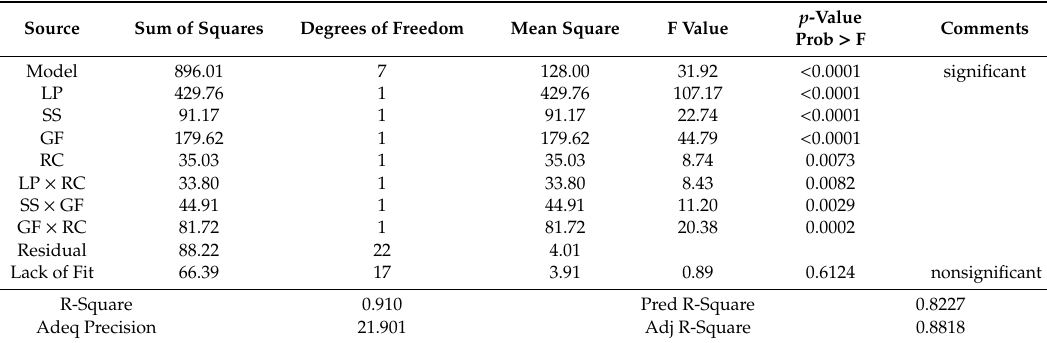
Table 6. Analysis of variance of dilution